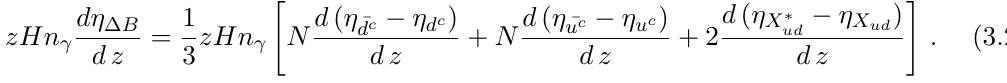
are in thermal equilibrium at the time of baryogenesis, see eq. (3.9). Again, we